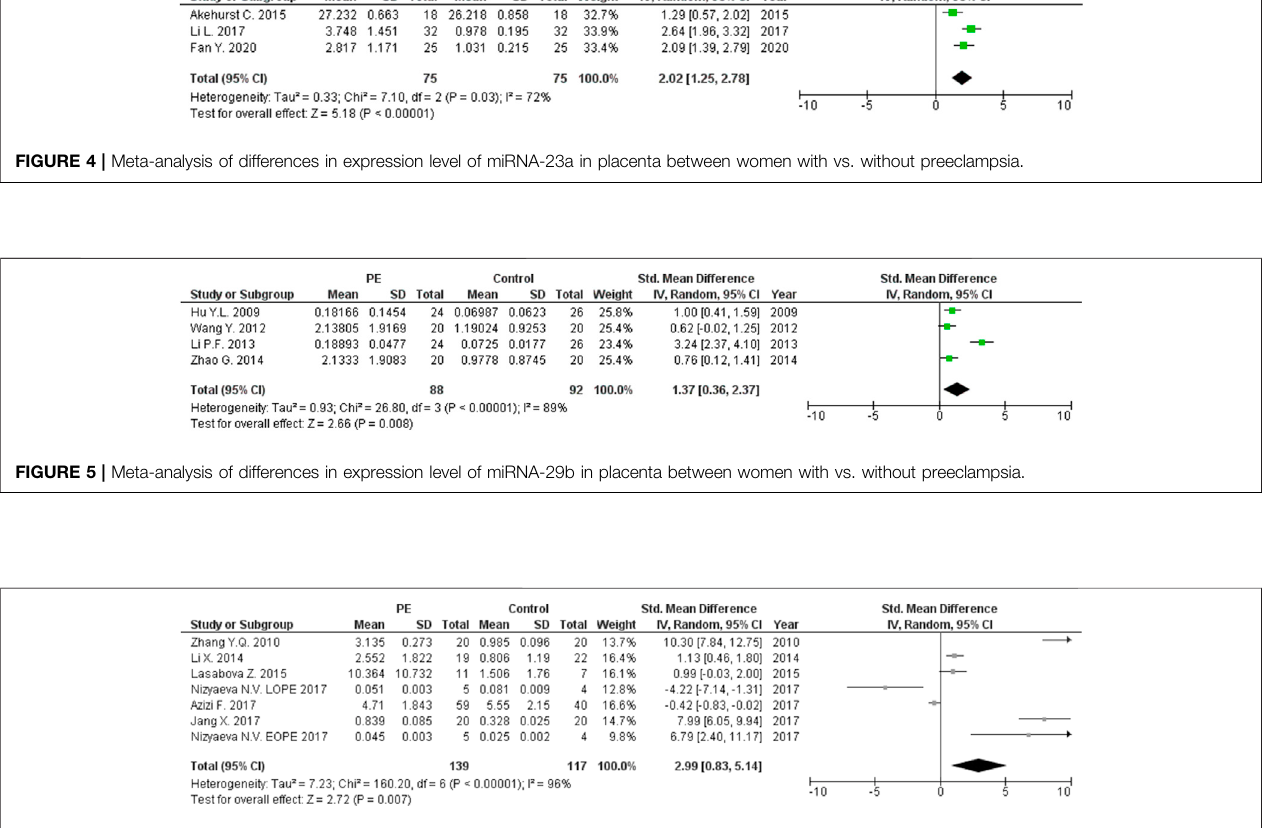
Frontiers in Bioengineering and Biotechnology |